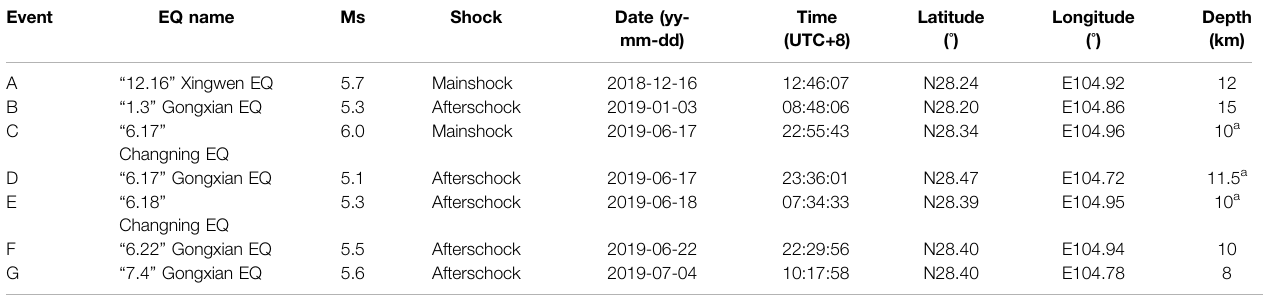
TABLE 1 | Earthquake parameters that were used in this